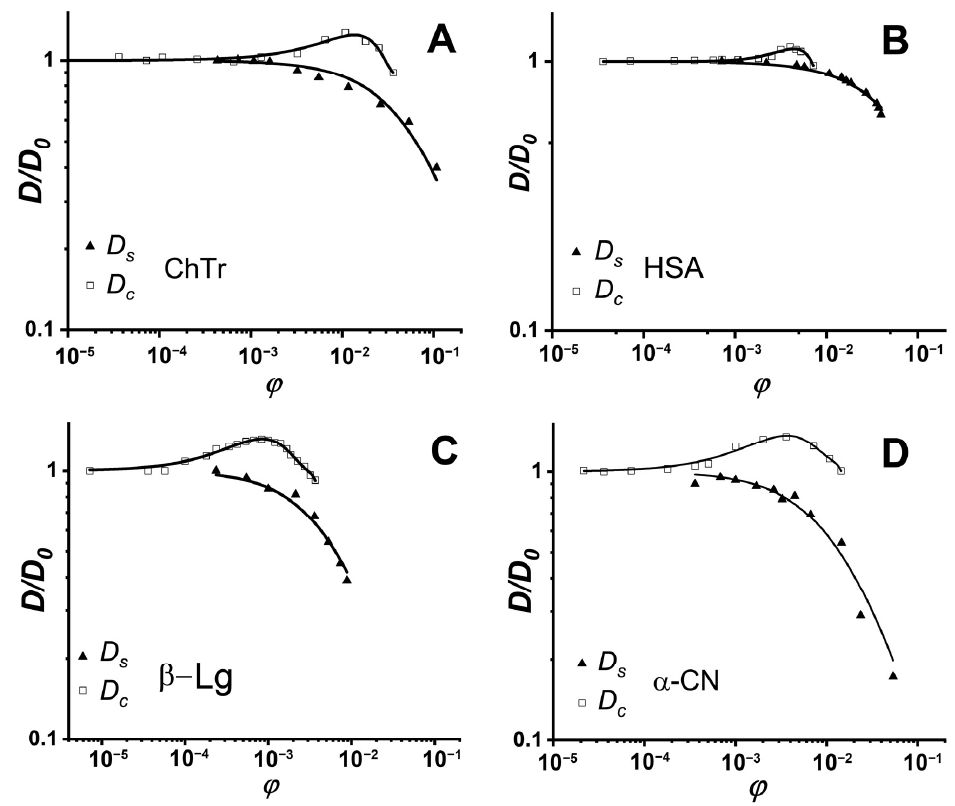
Figure 5. Normalized concentration dependencies of protein self- (triangles) and collective (squares) diffusion coefficients: ( A ) ChTr (pH = 3.5, I = 0.01 M); ( B ) HSA (pH = 7.2, I = 0.01 M); ( C ) β -Lg (pH = 7.0, I = 0.003 M); ( D ) α -CN (pH = 7.0, I = 0.01 M). Solid lines denote fits of experimental data by the